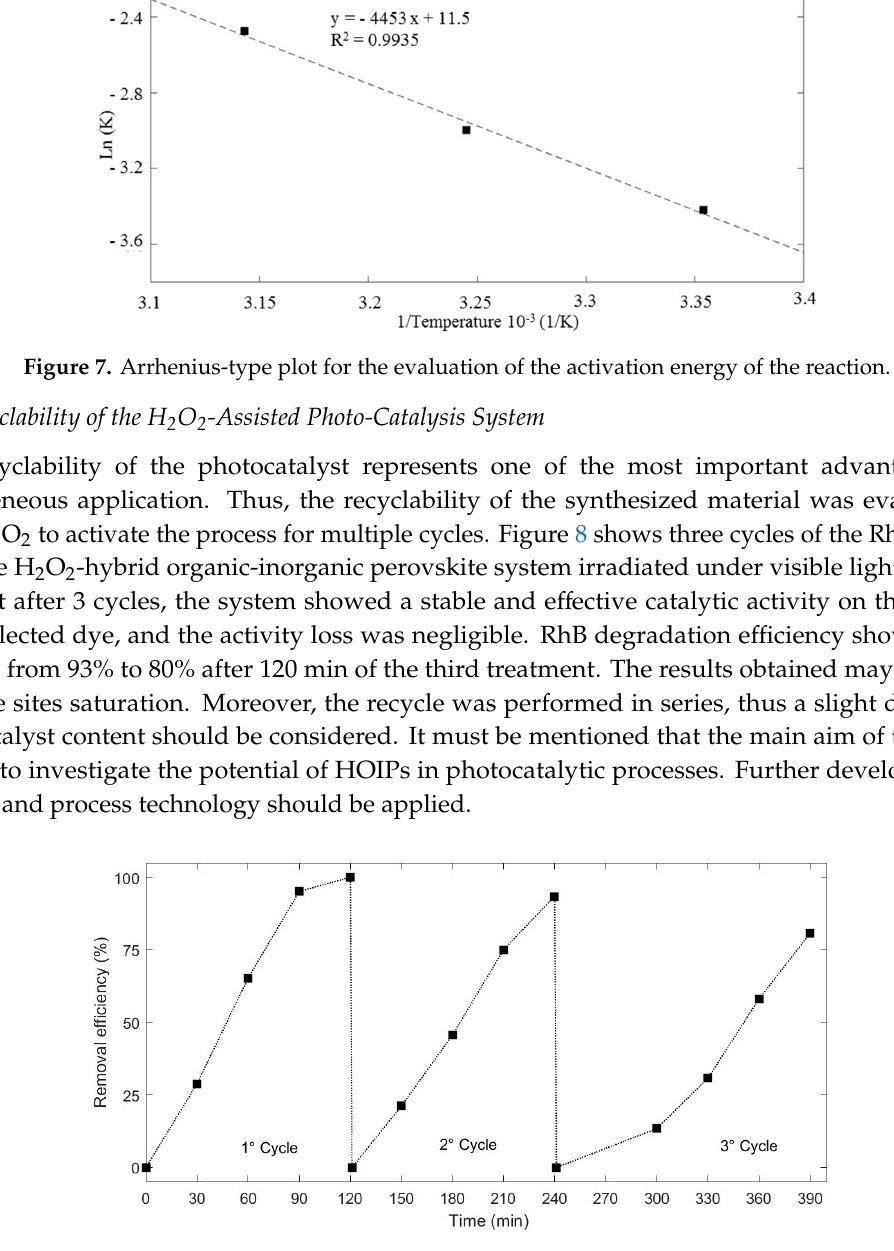
Figure 8. Degradation profile of RhB under assisted visible light photo-catalysis for three cycles .